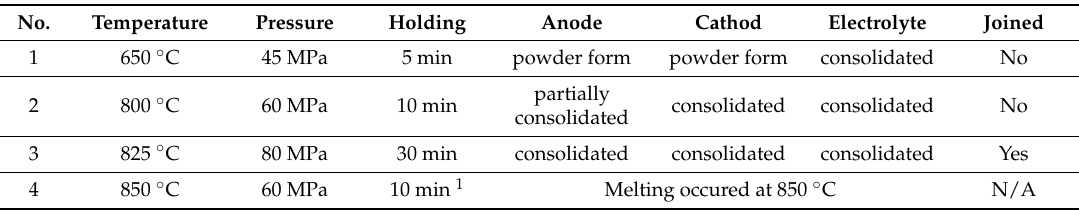
Table 1. Completeness of batteries’ consolidation under different spark plasma sintering (SPS) conditions.